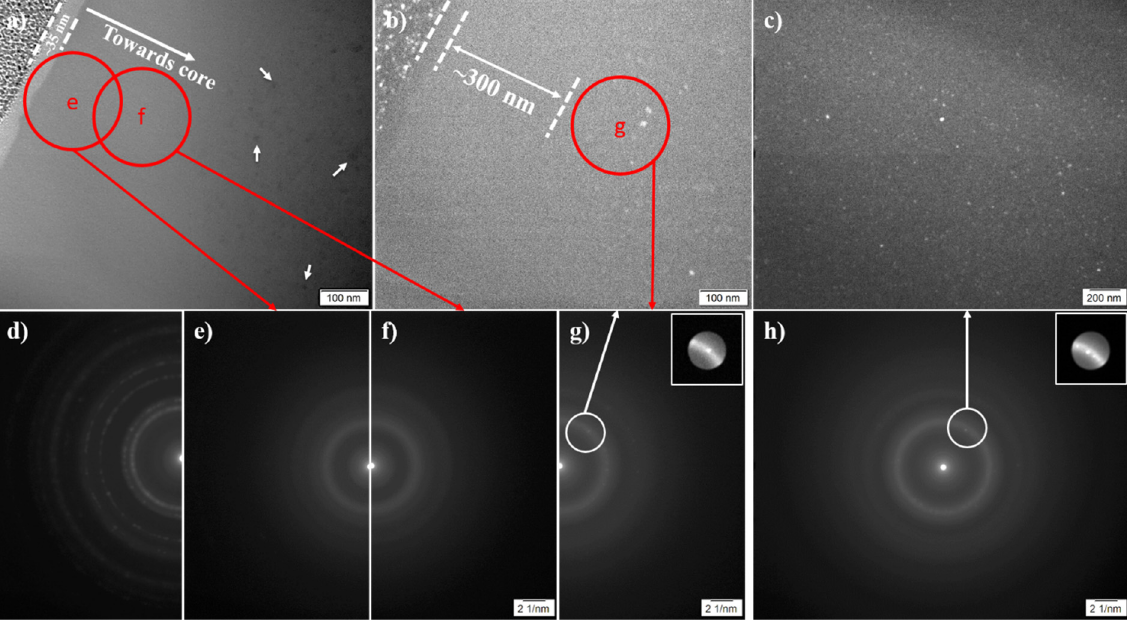
Figure 3. BF ‐ TEM image of 380 ‐ 4.5, showing a ) surface and b ) core ( ≥ 3 μ m deep). Figure 3. BF-TEM image of 380-4.5, showing ( a ) surface and ( b ) core ( ≥ 3 µ m